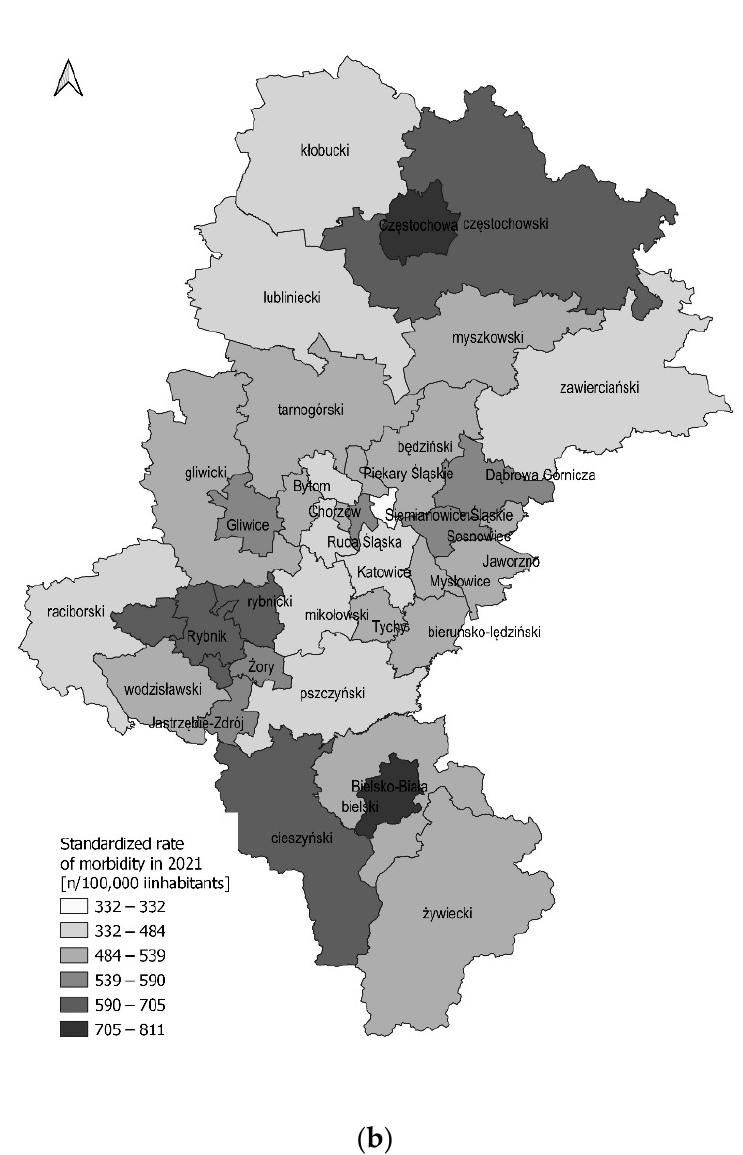
Figure 2. Standardized rate of hospitalized morbidity (n/100,000) due to COVID-19 in hospitals of the Silesian Voivodeship by counties in the years ( a ) 2020 and ( b ) 2021.